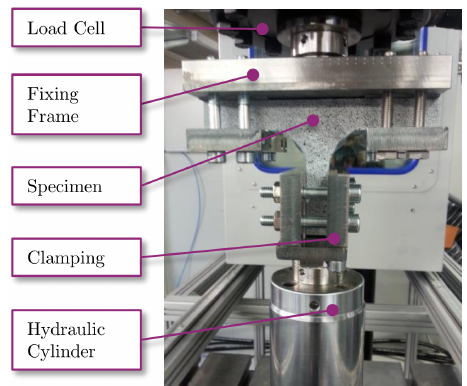
Figure 4. Subcomponent test